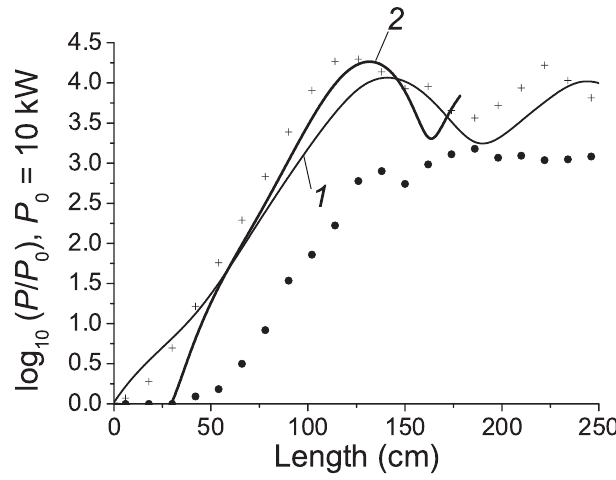
FIG. 3. Power of the CESTA FEM amplifier versus length: CESTA experimental (dots) and simulated (crosses) data [14]; results of simulation for cold beam: 1, from Ref. [22]; 2, by current 1.5D